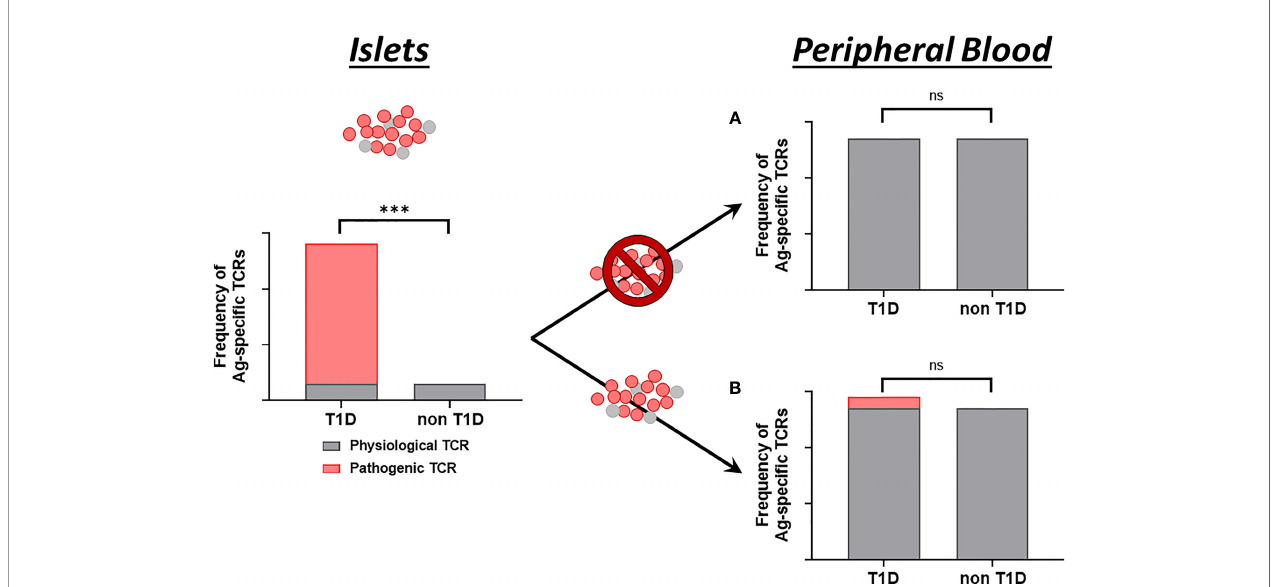
FIGURE 2 | Proposed models of islet-speci fi c T cell detection in the blood. While pancreatic islets contain a certain amount of T cells regardless of disease status (gray bars), only islets of individuals with T1D contain T cells that are highly reactive to islet antigens (red bar). Model (A) Leak of T cells from the islets to peripheral blood is limited. T cell repertoires speci fi c to islet antigens are not different between individuals with and without T1D. Model (B) There are substantial amounts of islet-speci fi c but not disease-speci fi c T cells in the blood regardless of disease status (gray bars). T cells in the islets do circulate in the blood (red bar), but the total numbers of islet-speci fi c T cells are not different between individuals with and without T1D. Enumerating only T cells derived from the islets can identify individuals having T1D. TCR clonotypes are a distinct property to identify islet-derived T cells. *** signi fi cantly different. ns, not signi fi